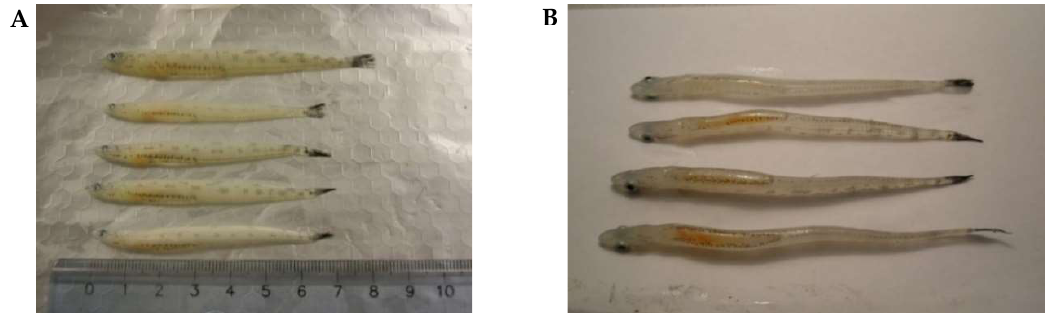
Figure 2. Pelagic postlarvae of L. maculatus (L3 stage of development) in summer. ( A ) A side view, ( B ) A view down the lipid sac.